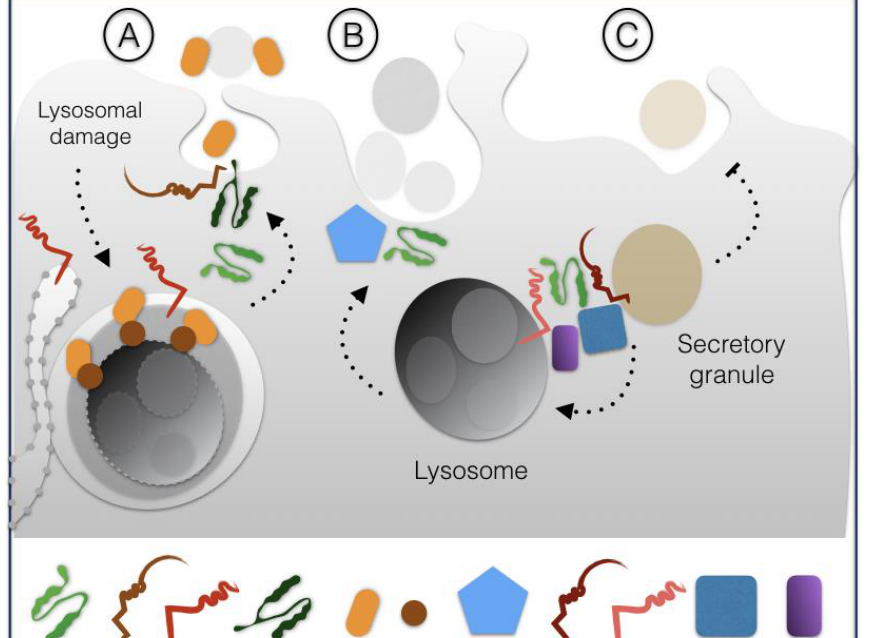
FIGURE 4 : Snap29 activity in secre- tion. Release of the pro- inflammatory factor IL-1β requires fusion to the plasma membrane mediated by Snap29 (A). Snap29 also regulates secretion of